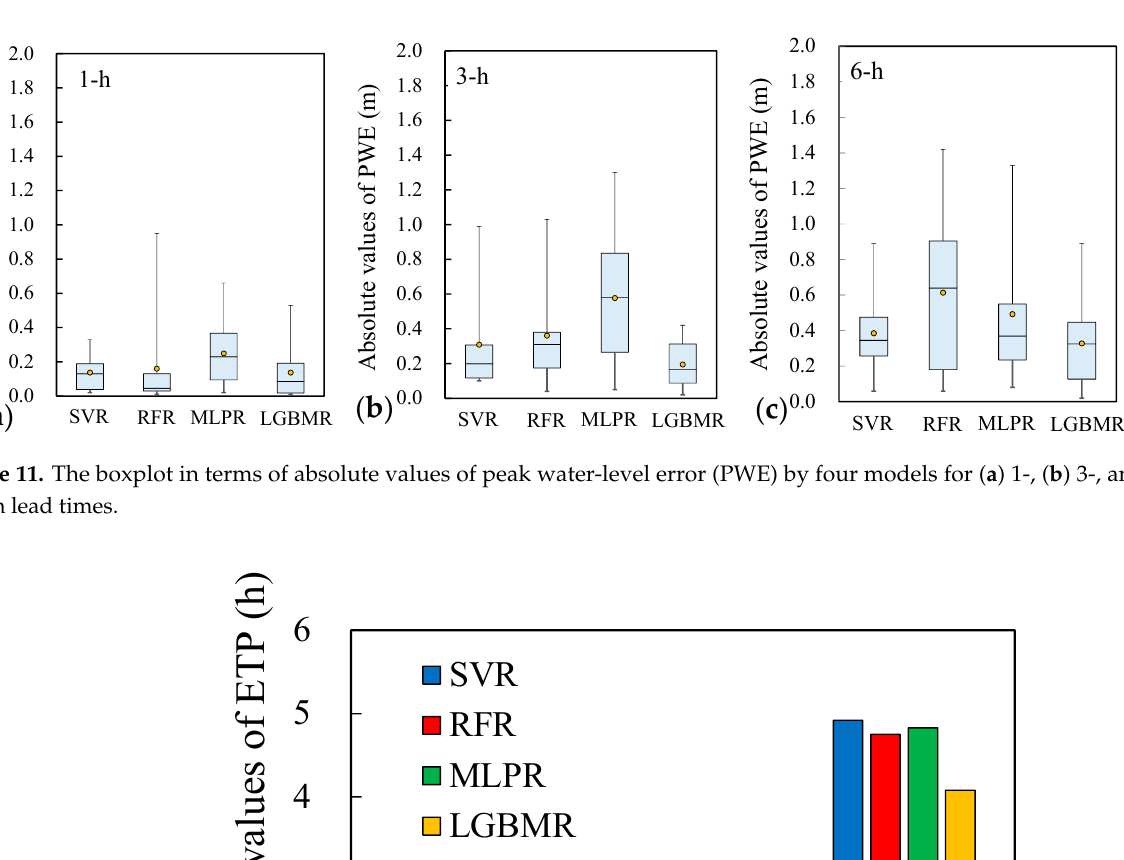
Table 9. The consumed CPU time by four models in training and validation processes.